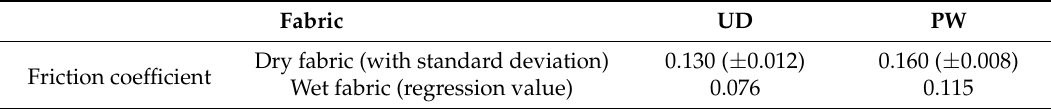
Table 3. Friction coefficients of unidirectional and plain woven carbon fabrics in their dry and wet states.